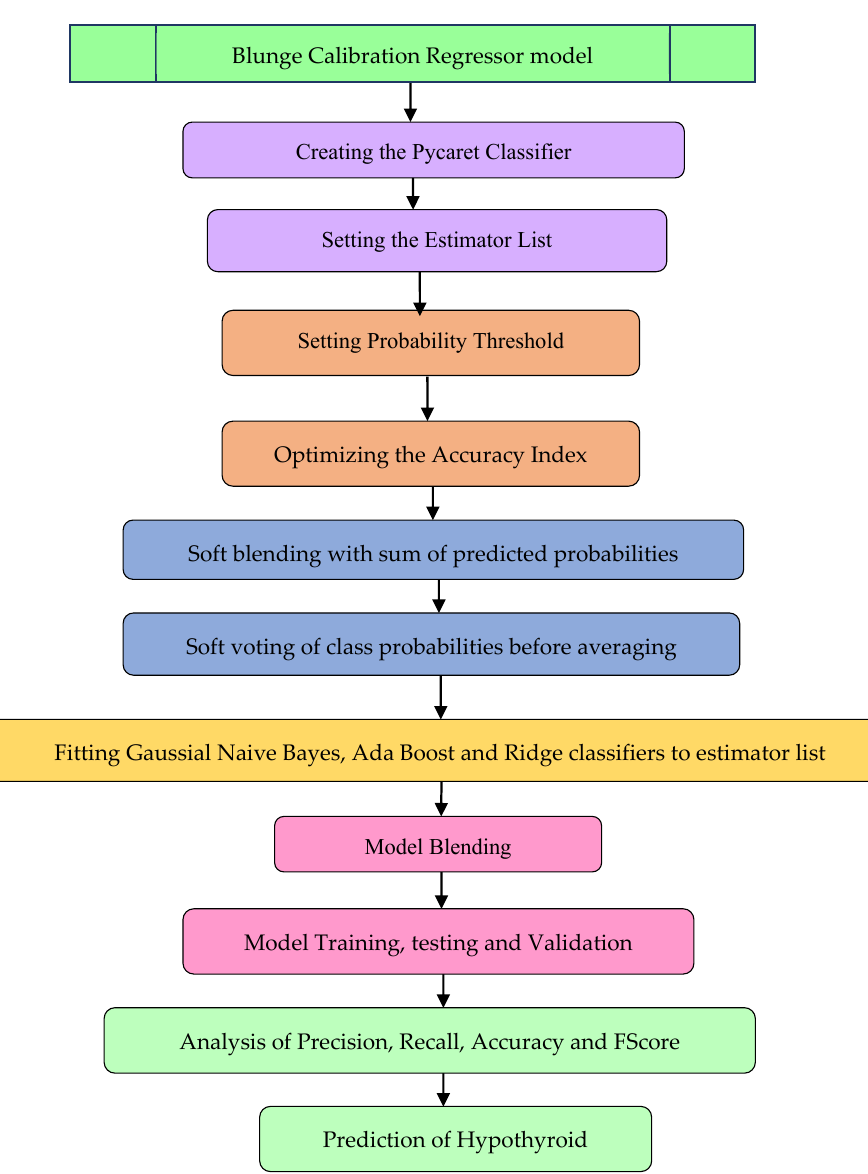
Figure 4. Blunge calibration regressor model workflow.